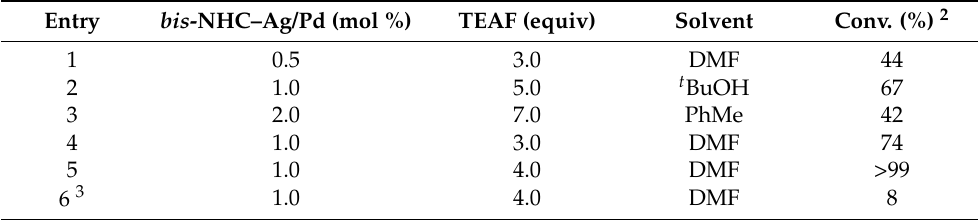
Table 1. Bis -NHC–Ag/Pd(OAc) 2 catalytic system catalyzed transfer hydrogenation reaction of trans -cinnamyl alcohol 1 . Entry bis -NHC–Ag/Pd (mol %) TEAF